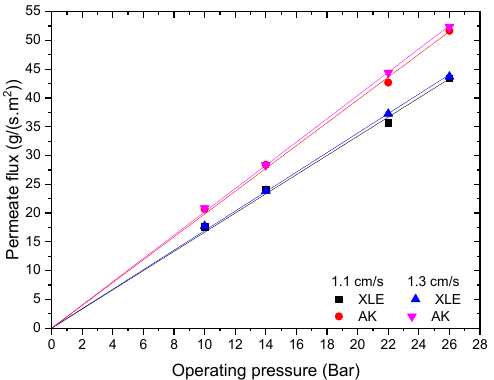
Figure 4. Permeate flux at two different cross flow velocities for a feed solution of 0.9 ± 0.1 g/L of lactic acid with no added KCl.